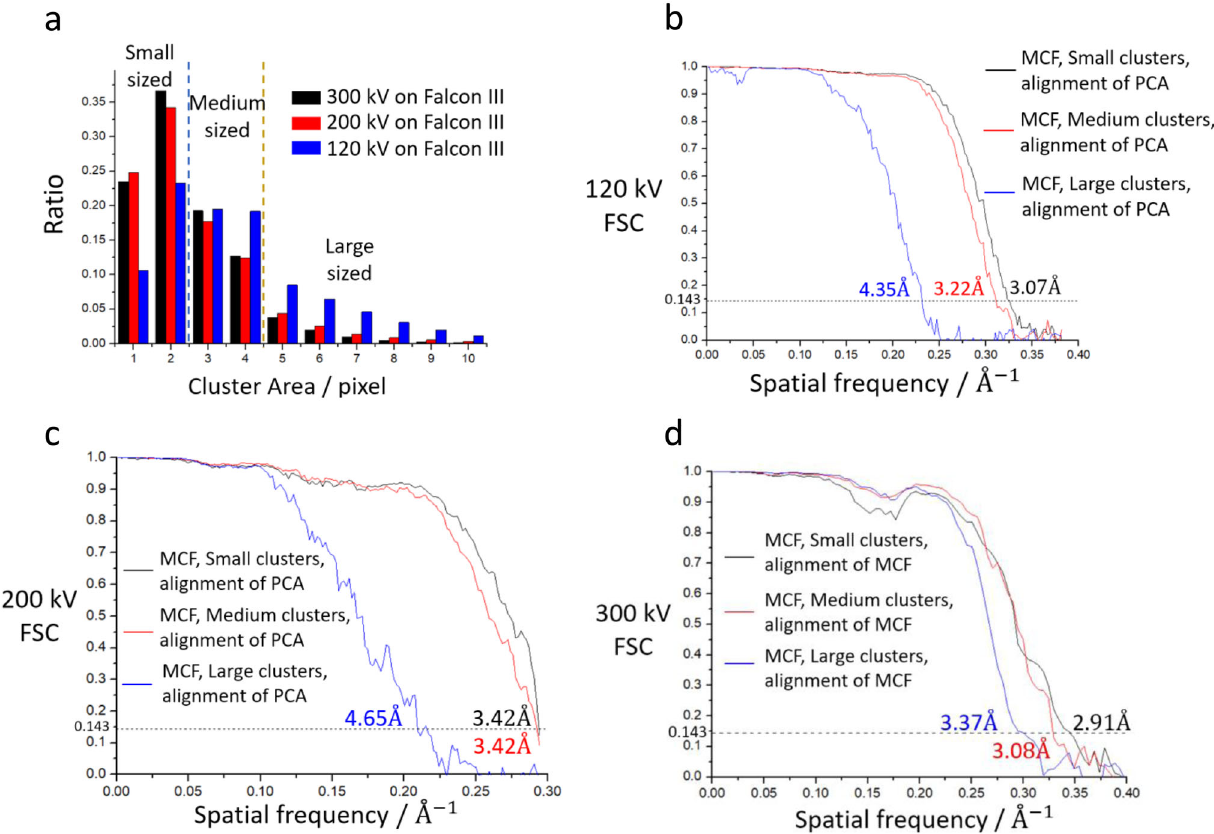
Fig. 2 Sizes of clusters and corresponding FSCs of Mass-Centre fi lter (MCF) algorithm. a The relative ratio with the same pixel of cluster area. ‘ Small- sized ’ , ‘ medium-sized ’ and ‘ large-sized ’ clusters are distinguished by blue and brown dash lines. b FSC curves of Coxsackievirus A10 at 120 kV with MCF counting algorithm. Each pair of reconstructions holds roughly the same number of clusters (~27% of total). PCA is short for Pattern Counting Algorithm we proposed. c FSC curves of Coxsackievirus A10 at 200 kV with MCF counting algorithm. Each pair of reconstructions holds roughly the same number of clusters (~10.8% of total). d FSC curves of apo-ferritin at 300 kV with MCF counting algorithm. Each pair of reconstructions holds roughly the same number of clusters (~7.9% of total). All the resolution of reconstructions based on gold-standard FSC criterion marks on the